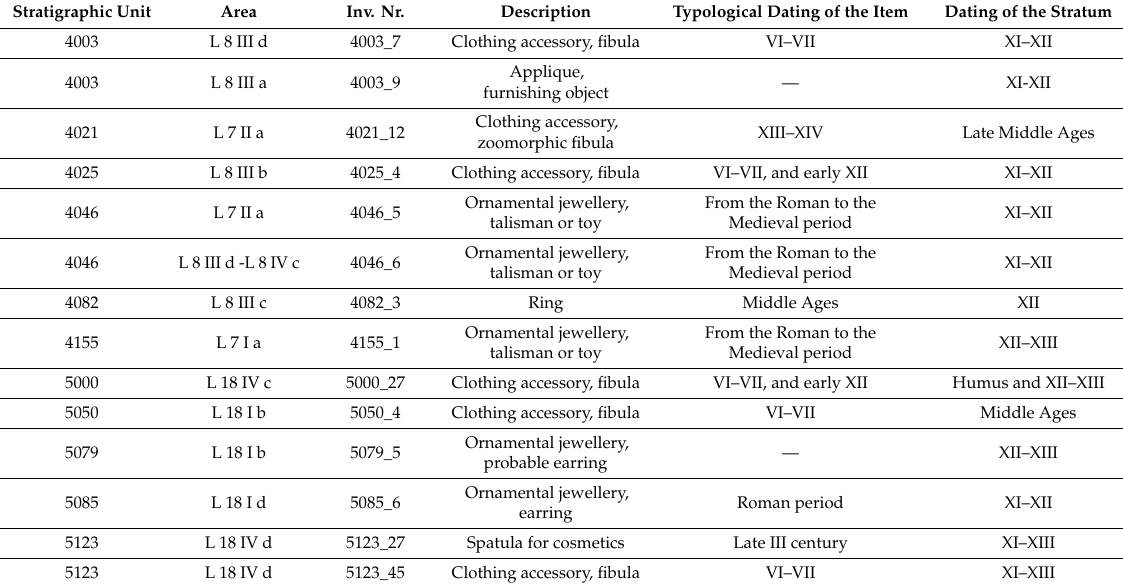
Table 1. Examined objects, according to the classification made by archaeologists